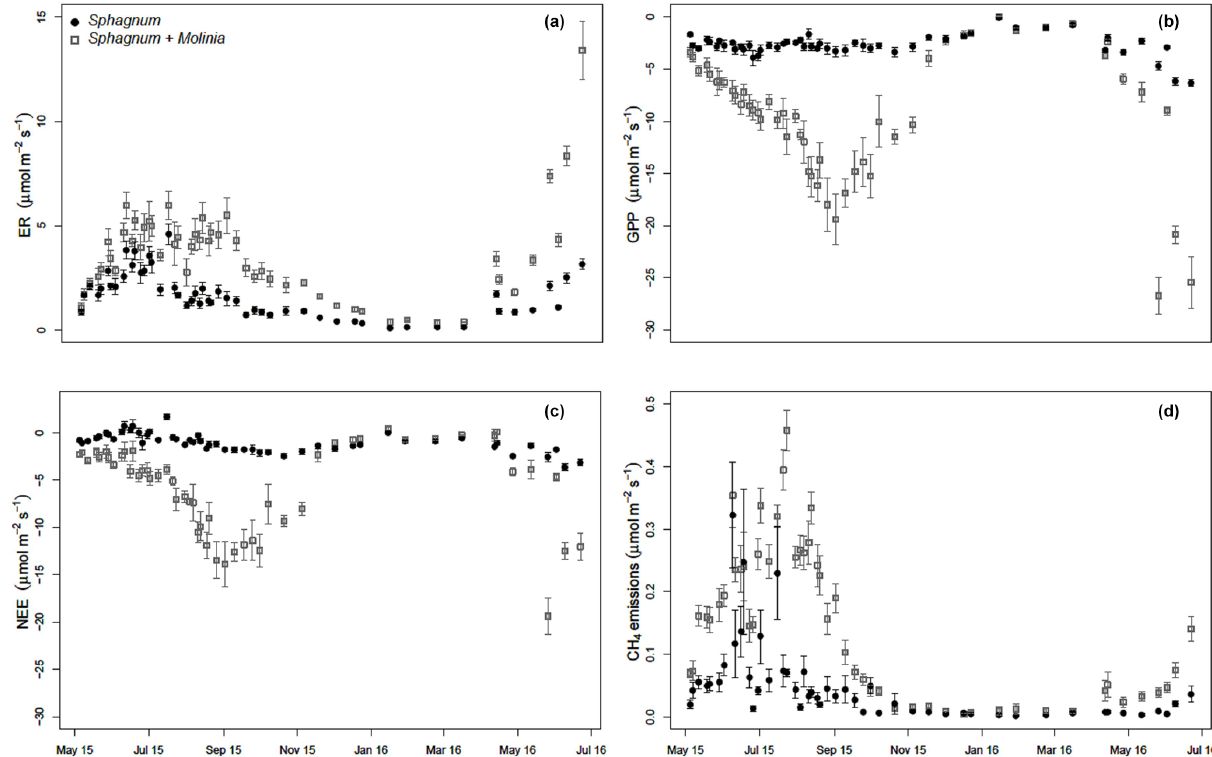
Figure 1. Measurements of ecosystem respiration (ER; a ), gross primary production (GPP, b ), net ecosystem exchange (NEE, c ) and CH 4 emissions (d) in Sphagnum and Sphagnum + Molinia plots ( ± SE; n = 6) from May 2015 to June